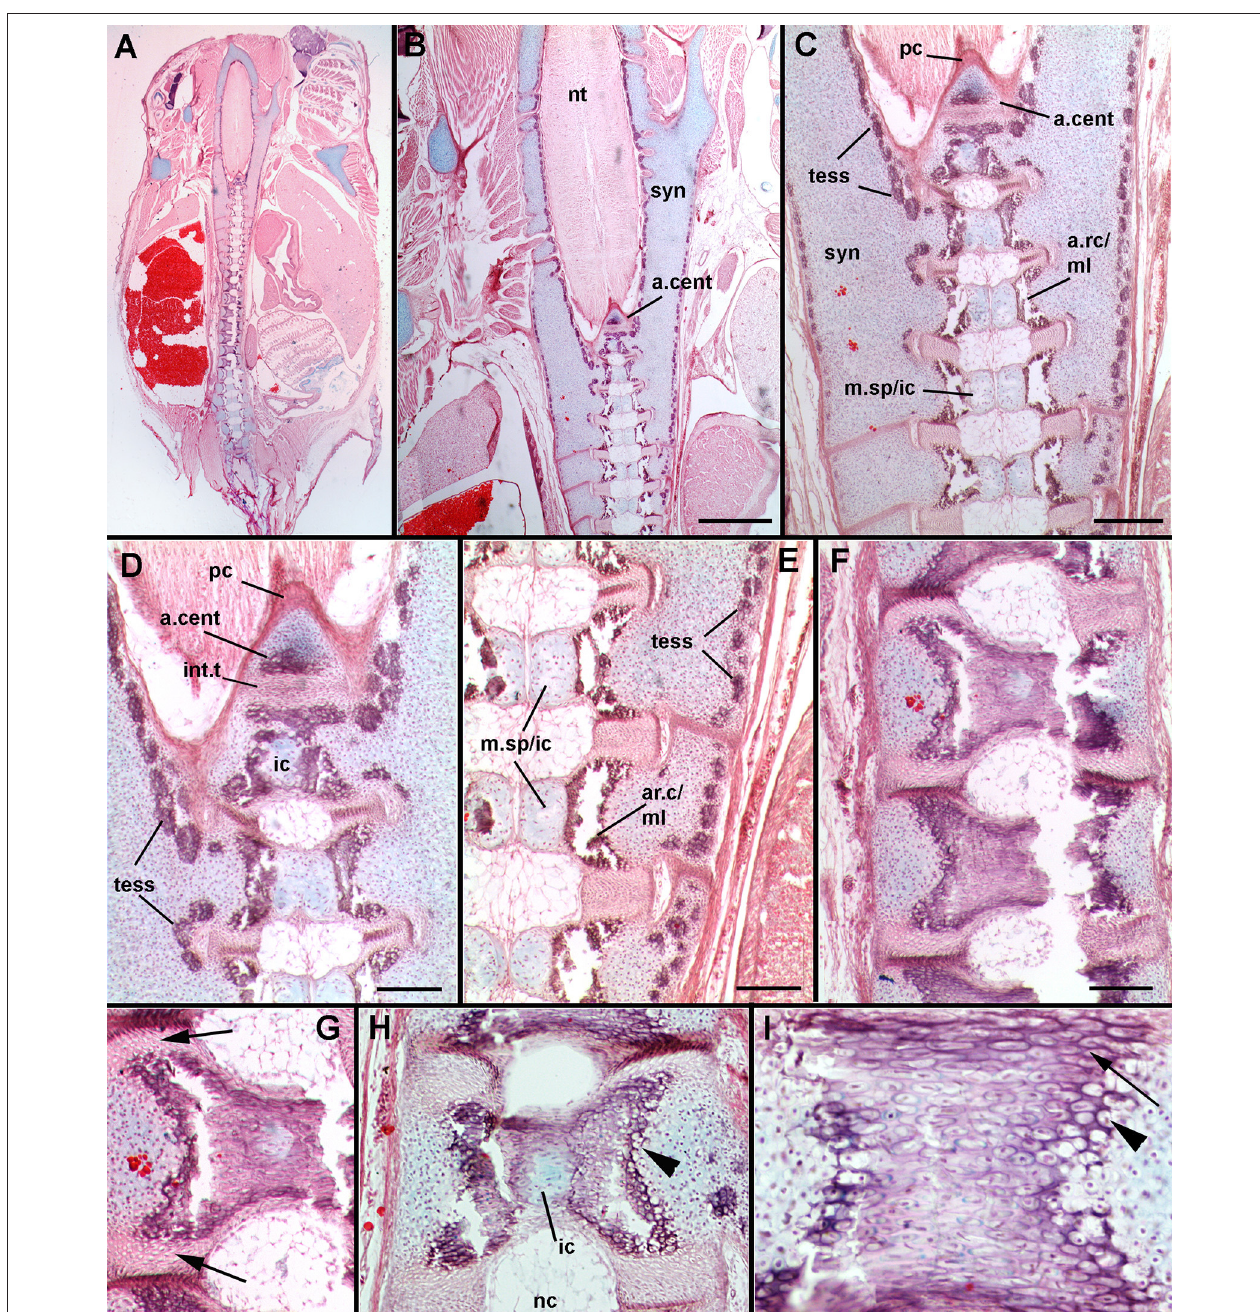
FIGURE 8 | Leucoraja erinacea , st. 33, horizontal sections, stained with alcian blue, haematoxylin and eosin. (A) Overview of vertebral column and synarcual; (B) closeup of posterior synarcual and separate vertebral column (central axis), including anteriormost centrum; (C) closeup of posterior synarcual and anterior vertebral axis, with anteriormost centrum and surrounding perichondrium; (D) closeup of area indicated in (C) showing differences between internal cartilage and anteriormost centrum, tesserae developing along cartilage surfaces; (E) closeup of central vertebral axis, with internal cartilage developing within medial cartilages and meeting in midline, areolar mineralization in centra occuring in middle layer; (F–I) mineralizing centra, showing contribution of cells from the outer layer of cartilage ( H,I , black arrowheads) and intervertebral tissue ( G,I , black arrow). Mineralization is occurring around inner layer of cartilage (H) . Abbreviations as in Figures 1 – 7 , also: a.cent, anteriormost centrum; ar.c/ml, areolar cartilage/middle layer; ic, internal cartilage layer; m.sp/ic, medial space/internal cartilage layer. Scale bars: (B–F) = 2mm. deposit extracellular matrix resulting in interstitial cartilage growth, while growth can also be appositional, via addition to the cartilage